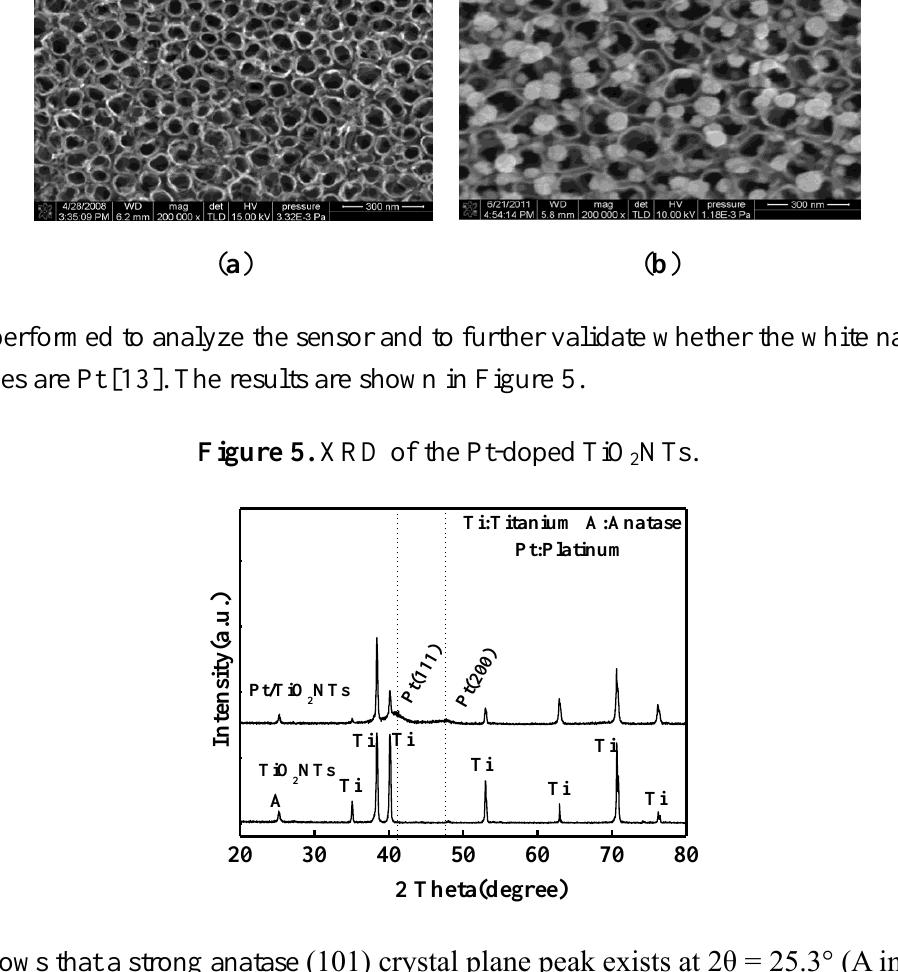
Figure 4. SEM images of the intrinsic and Pt-doped TiO ( b ) Pt-doped TiO